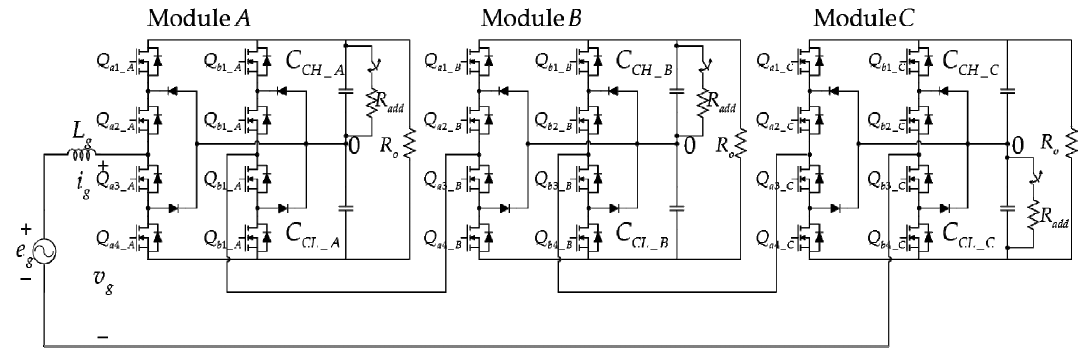
Figure 2. Single-phase three-level neutral-point-clamped (NPC) converter with additional switch circuit on the upper capacitor.